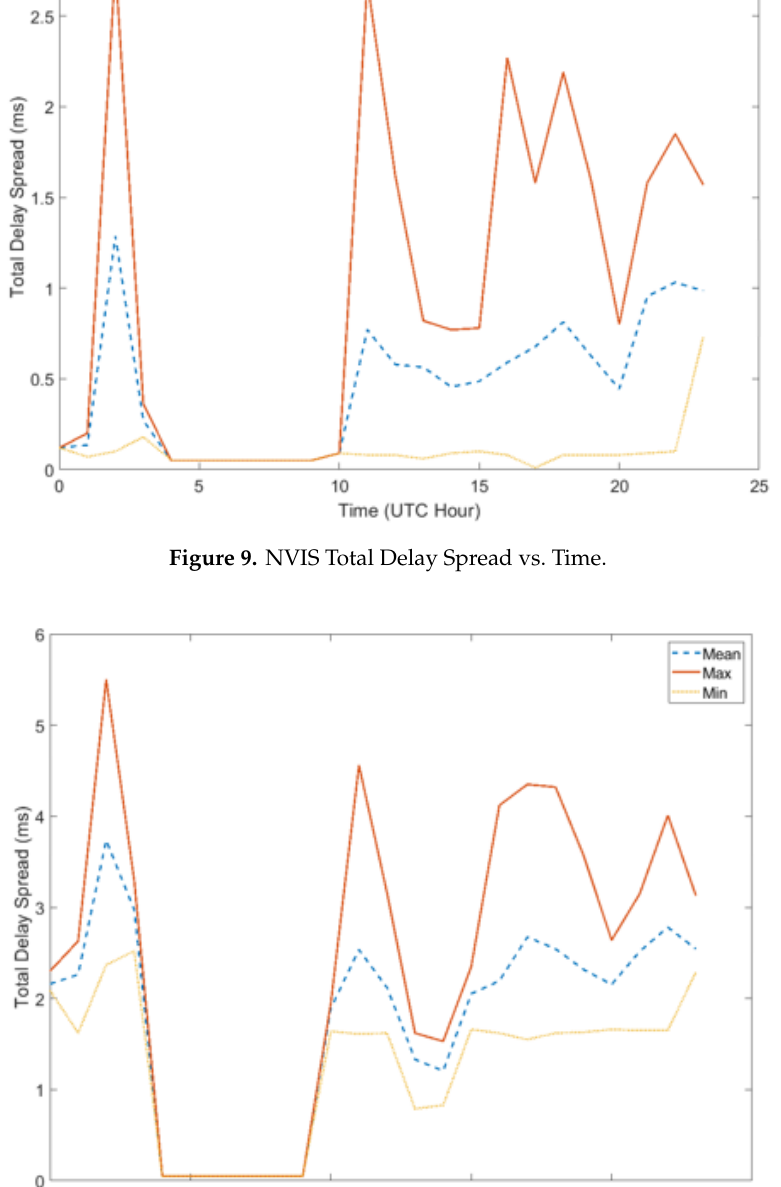
Figure 9. NVIS Total Delay Spread vs Time.